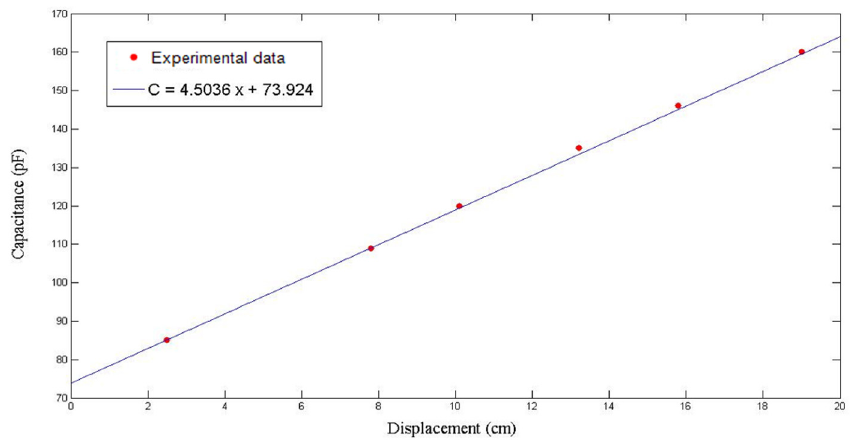
Figure 17. Capacitance measured during the second RTM experiment using a seven-layer fiber preform.